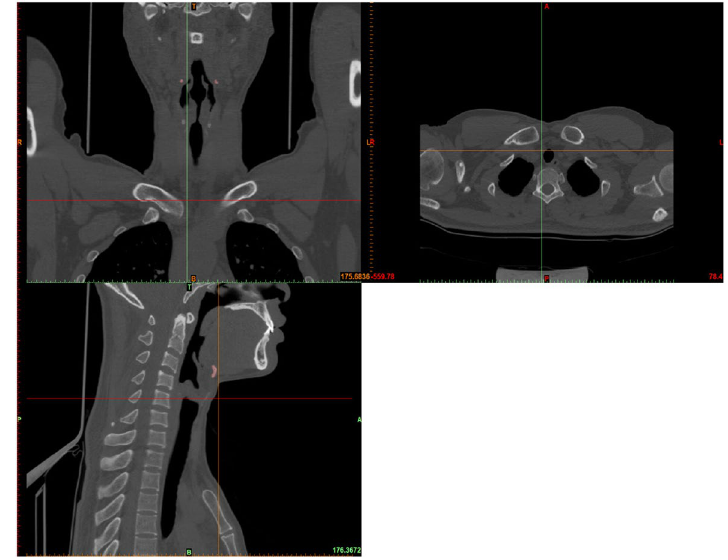
Figure 2. CT image displayed in the GUI of 3D modelling software from different views.